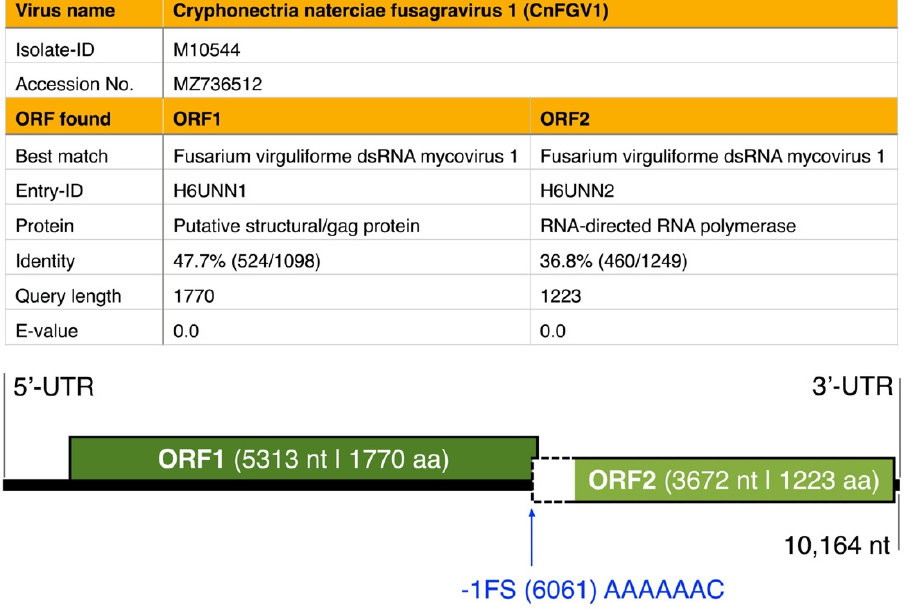
Figure 3. Best matches of BLASTp searches (UniProt) and schematic genome organization of the new mycovirus Cryphonectria naterciae fusagravirus 1 (CnFGV1) found in the Portuguese isolate M10544 of Cryphonectria naterciae . The genome of CnFGV1 contains two predicted open reading frames (ORFs; green boxes). A putative shifting heptamer sequence located at site 6061 nt upstream of the stop codon of the hypothetical protein ORF1 is shown in